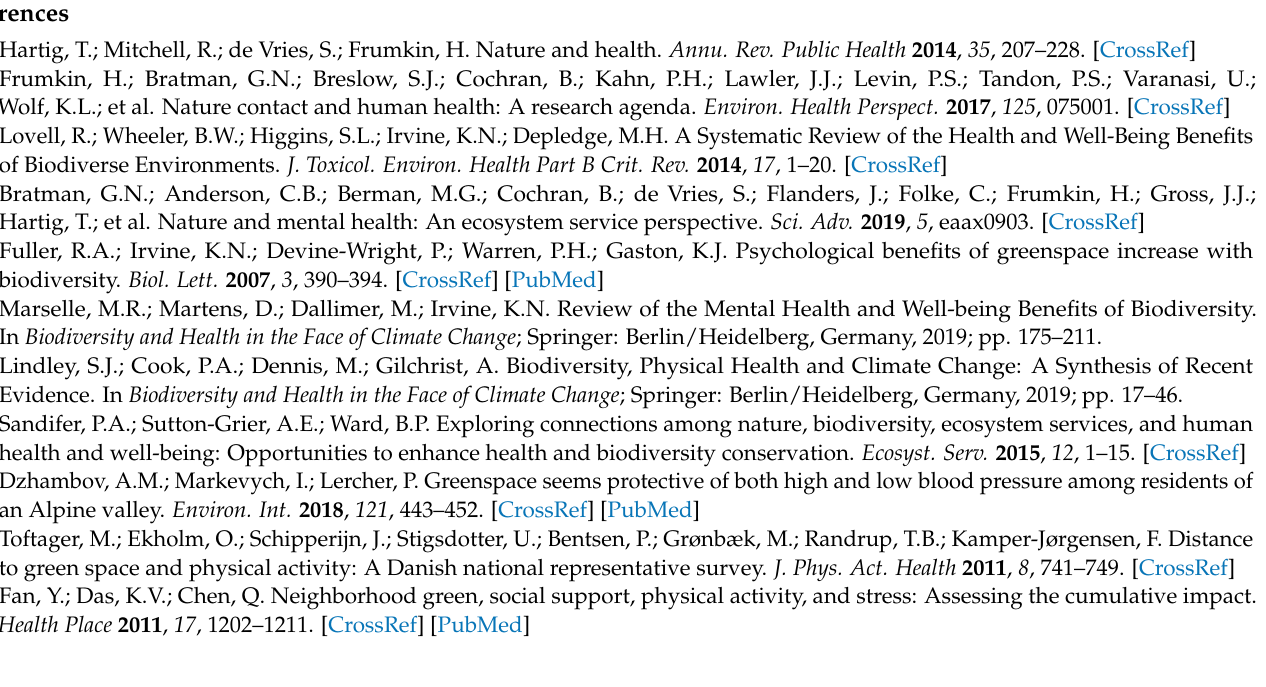
respondents, Table S2. Example conversions of the participants’ full text to short phrase meaning units (MUs), Table S3. Inter-rater reliability scores for each question using Cohen’s kappa value (McHugh